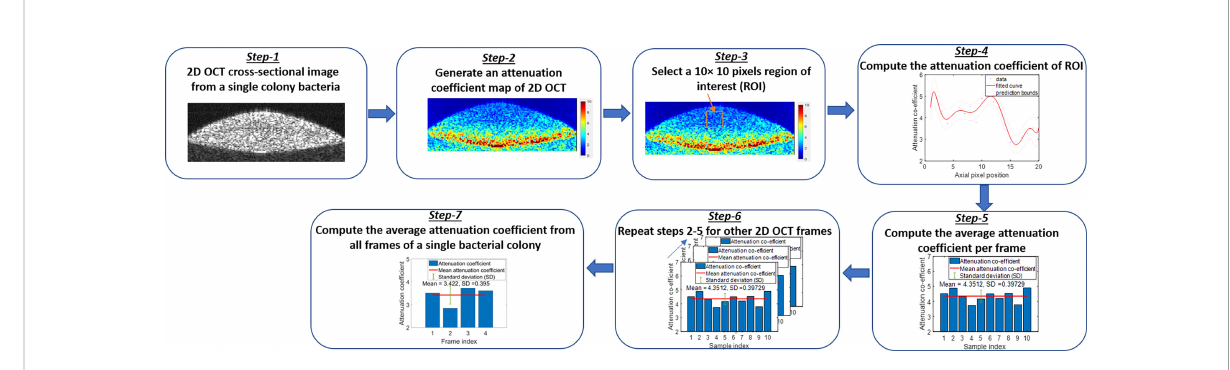
FIGURE 8 Flow diagram of the attenuation coef fi cient calculation